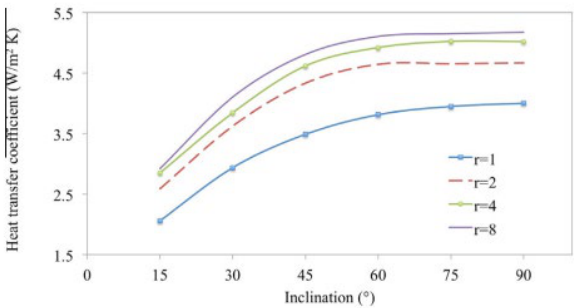
Figure 26. Heat transfer coefficient variation in inclined rectangular cavities. Reprinted with permission from Ref. [47]. 2016, Elsevier.